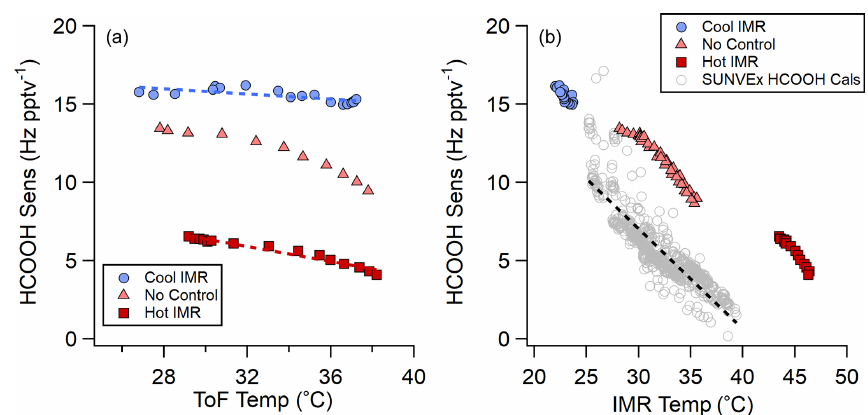
Figure 7. Comparison of absolute HCOOH sensitivity between laboratory IMR temperature experiments (ARI IMR design) and SUNVEx field standard additions (NOAA IMR